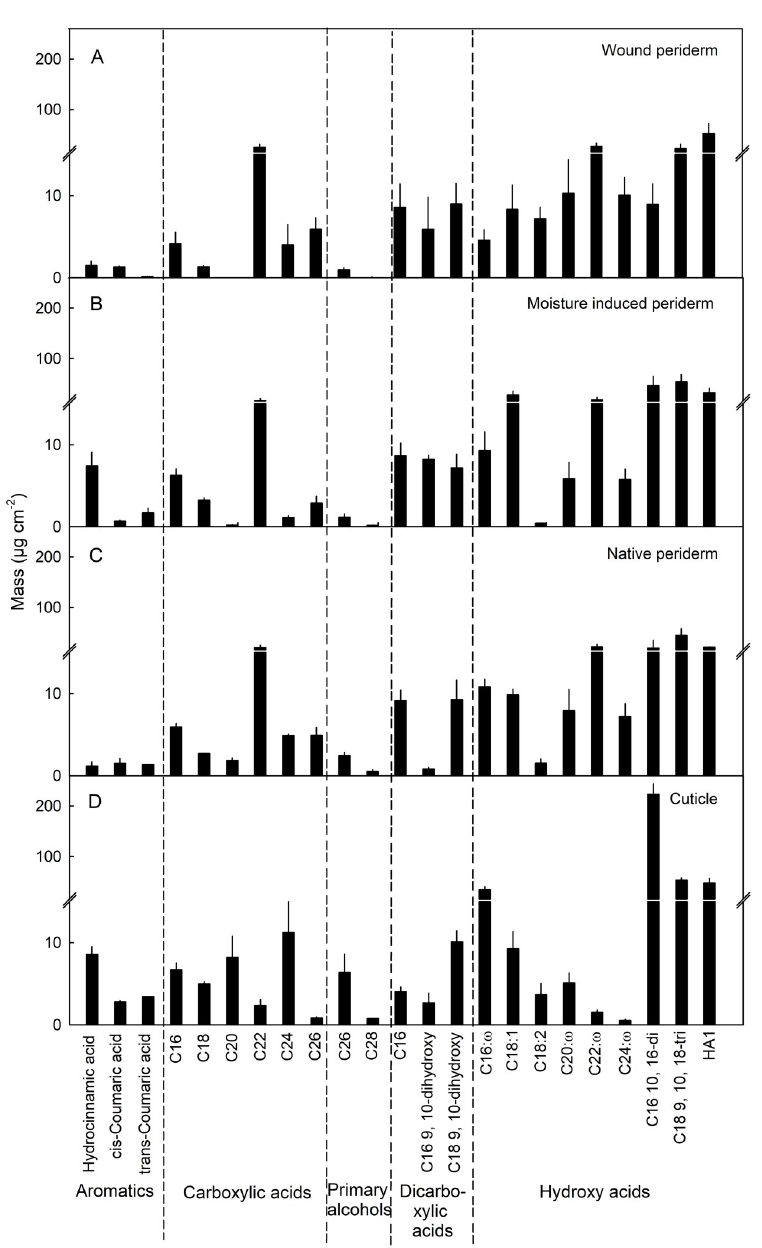
Fig 6. Composition of cutin and suberin of skins of mature apple fruit. Periderm formation in the fruit skin was induced during early development by abrading the cuticle using abrasive paper (‘Wound periderm’) (A) or by exposing the fruit skin to surface moisture for 12 d between 31 and 43 days after full bloom (DAFB; ‘Moisture-induced periderm’) (B). The treated patches of skin were excised at maturity 156 DAFB. Native periderm from naturally russeted fruit (C) and cuticles from non-treated non-russeted fruit served as controls (D). Data represent means ± SE of two to three replicates comprising periderms and cuticles of five fruit each. The data shown in (B) were taken from Straube et al.